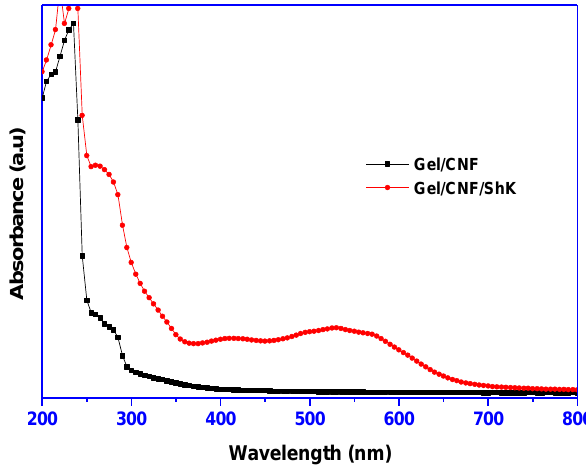
Figure 2. UV-vis absorption spectra of the smart films.